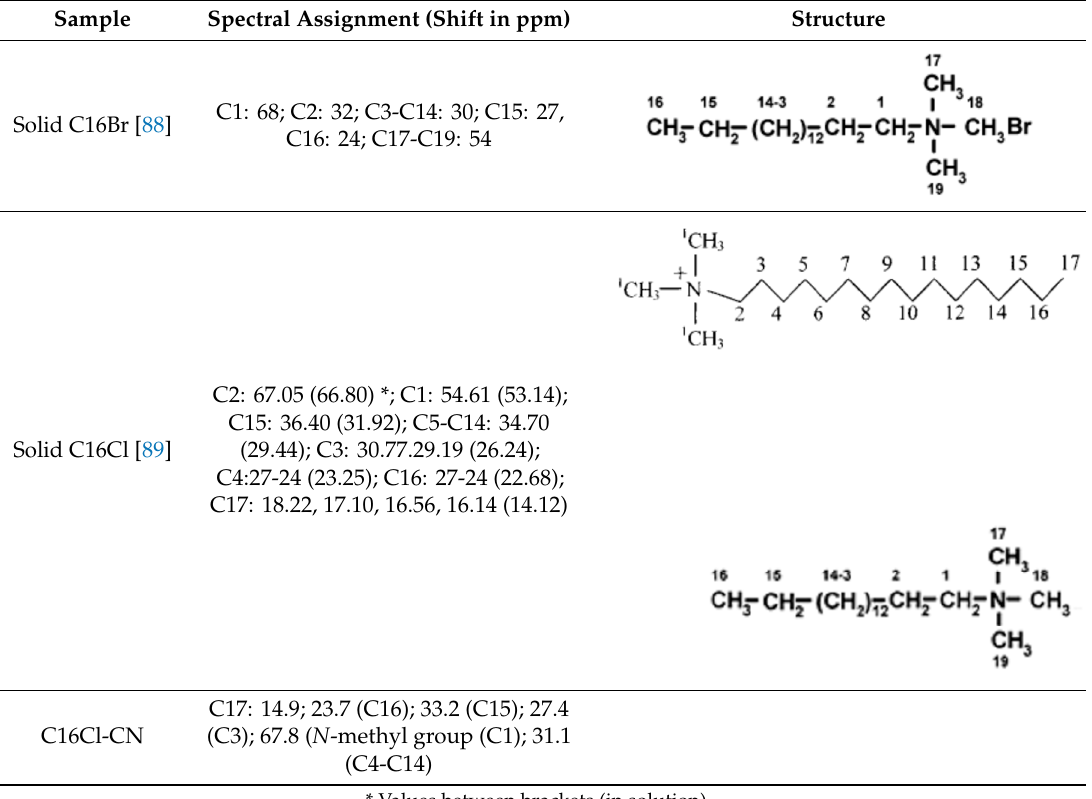
Table 3. Solid 13 C-CP-NMR resonance signals and their assignments for the C 16 surfactant used.